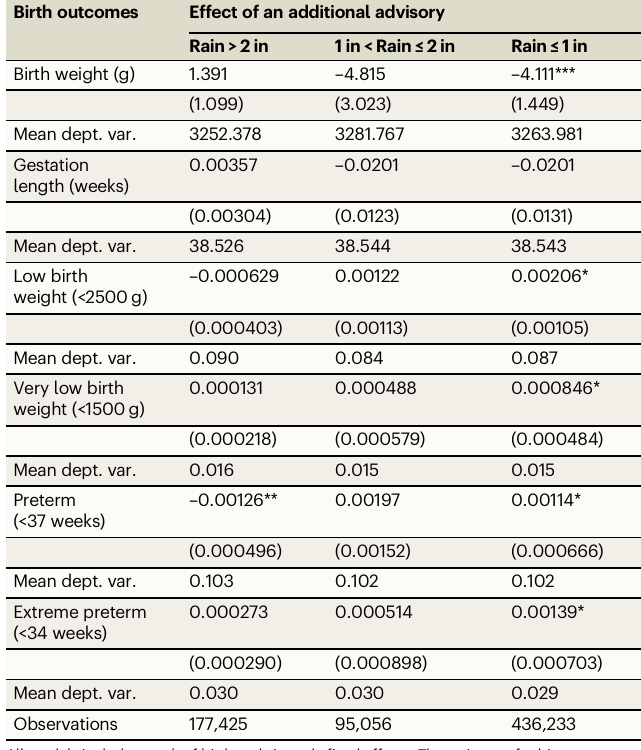
Table 1 | Treatment effect of an additional 6-h “ Cone of Uncertainty" advisory Birth outcomes Effect of an additional